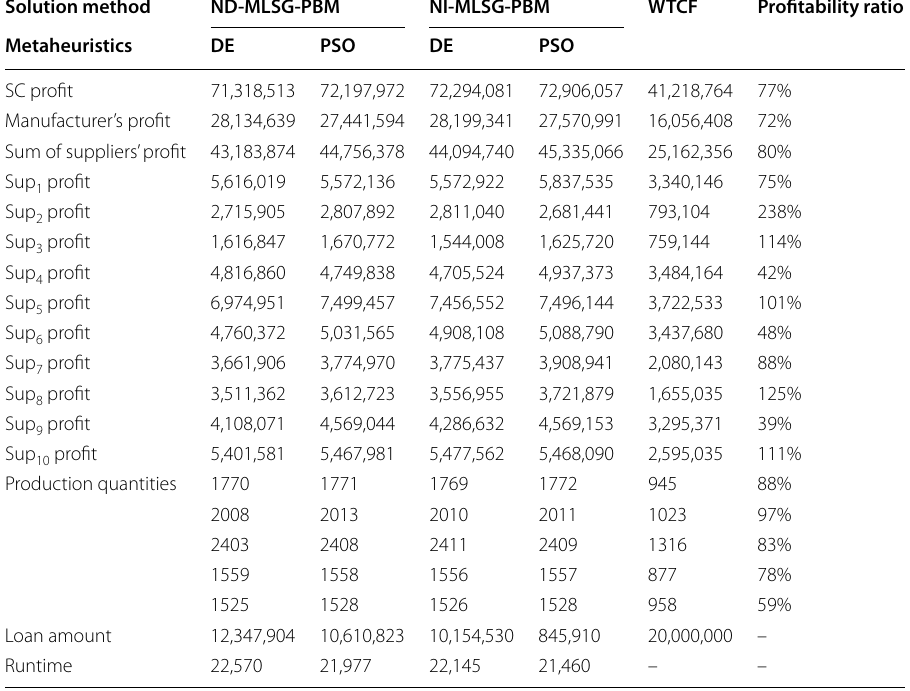
Table 8 A summary of the results for TCF contract in Sc-2 and WTCF case for the test problems in size